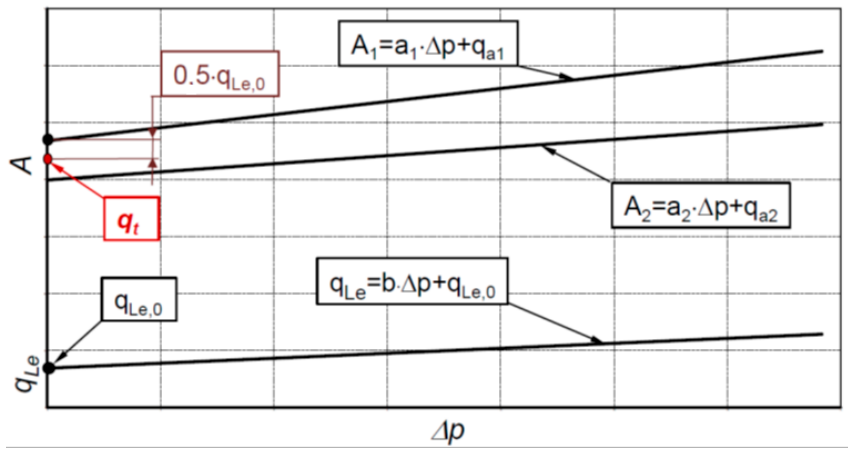
Figure 3. Linear relationship between working volume A and leakage q Le and pressure difference ∆ p